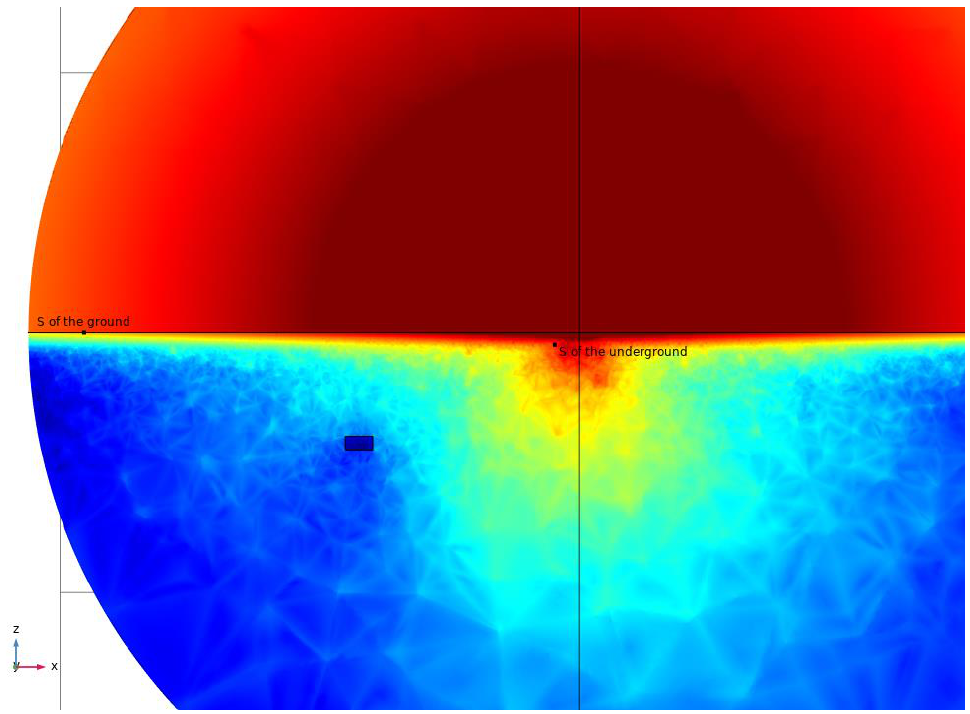
Figure 19. The plane wave principle for a bi-static antenna GPR for deep exploration.